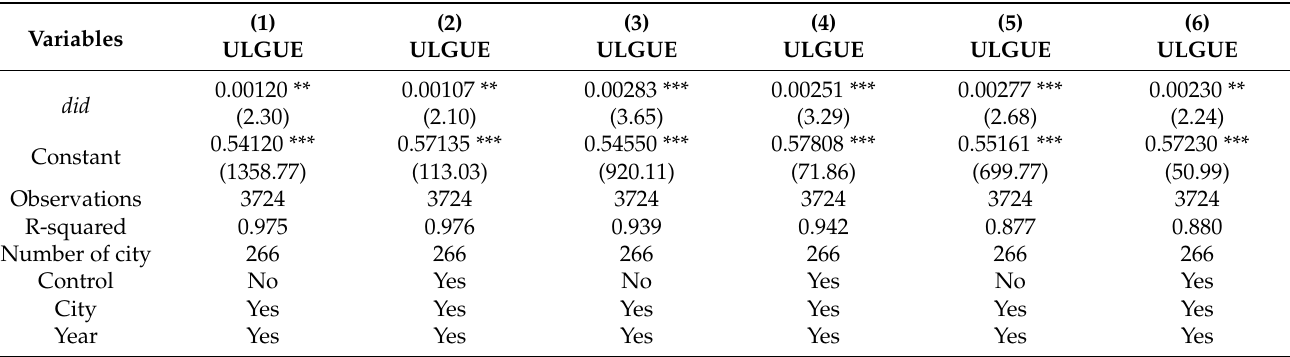
Table 5. Robustness